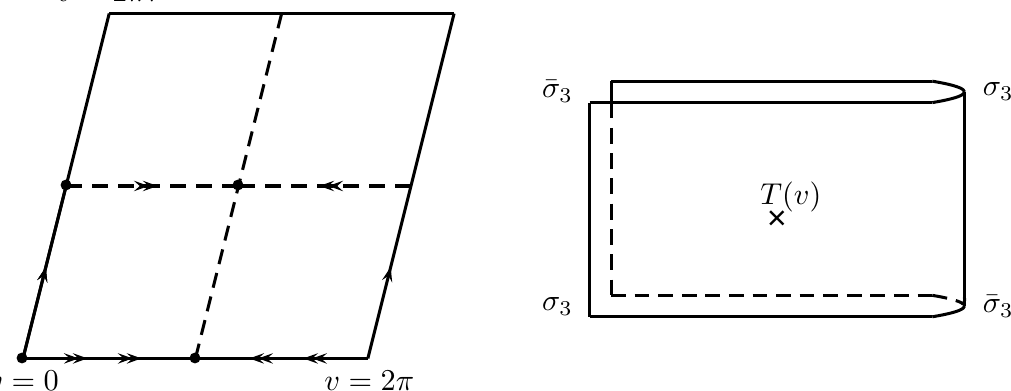
Figure 2 . Left : the pillow geometry is the quotient T 2 = Z 2 . The four branch points on the plane 0 ; z; 1 ; 1 are mapped to the Z 2 (cid:12)xed points v = 0 ; (cid:25); (cid:25) ( (cid:28) + 1) ; (cid:25)(cid:28) respectively. Right : the